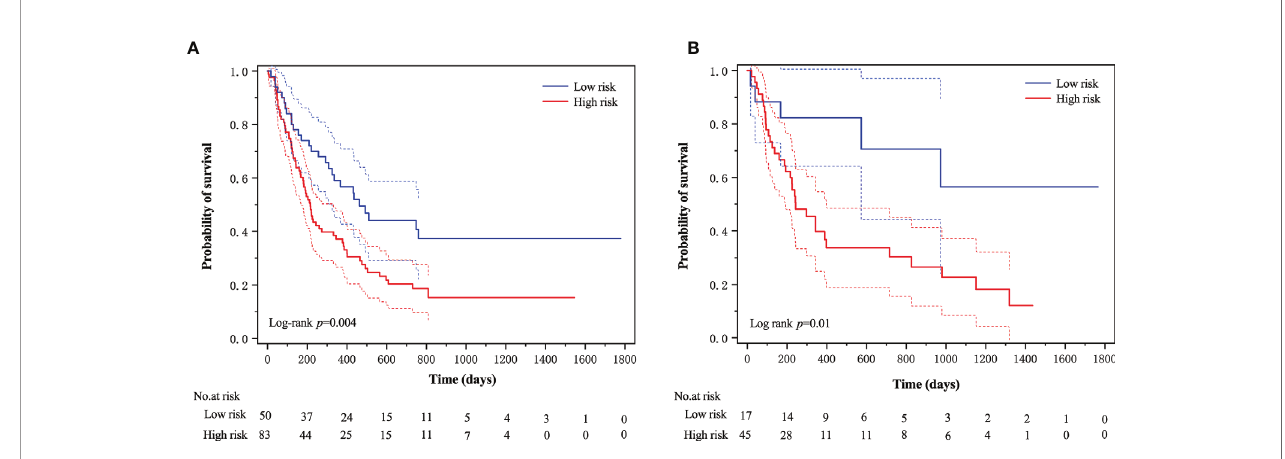
FIGURE 4 | The Kaplan – Meier survival curves of the low- and high-risk groups according to the log-rank test for patients in (A) training cohort and (B) validation cohort. The vertical dashed line is 95% con fi dence interval.